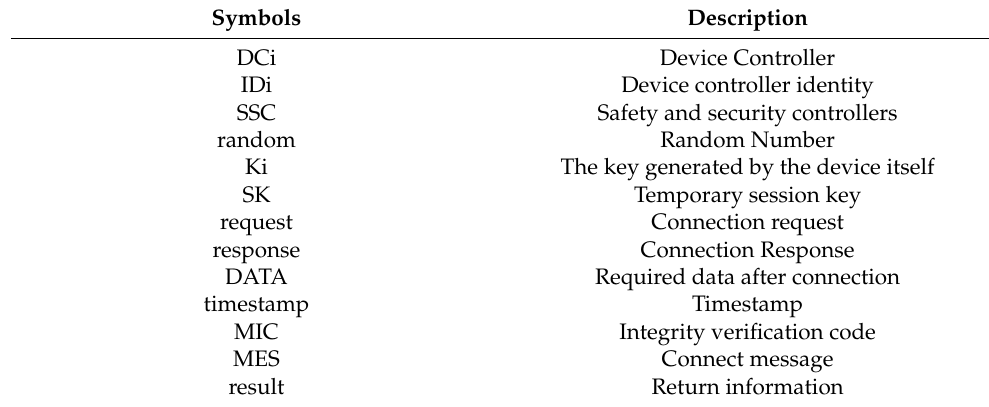
Table 1. Symbols and